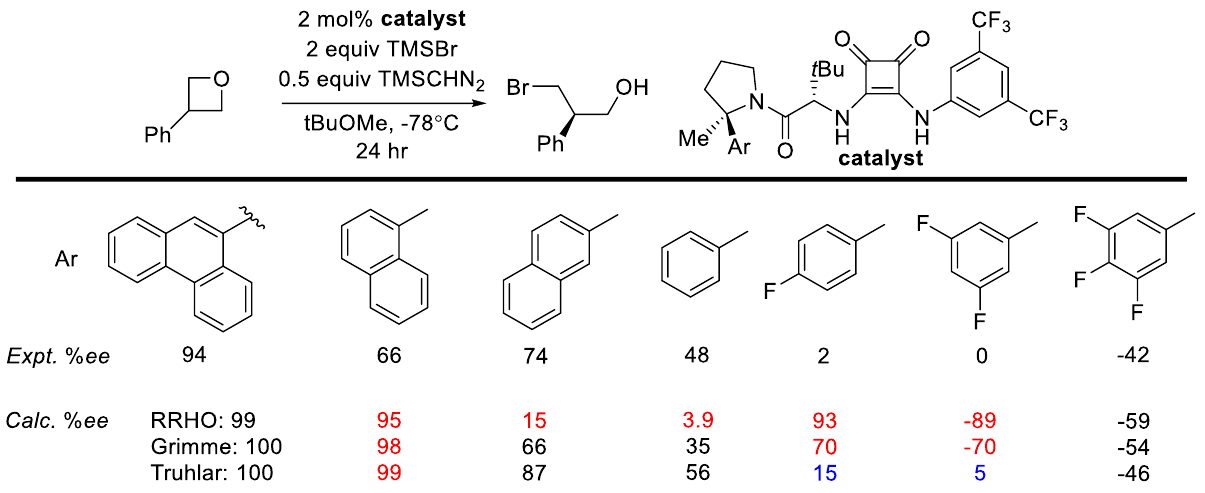
Figure 26. Squaramide-catalyzed enantioselective oxetane opening. Values are from the work of Jacobsen and co-workers [89]. Only the Lewis acid mechanism result is shown here. % ee are calculated from the ΔΔ G ‡ 195.15K, 1atm calculated at SMD(Et 2 O)/B97D3/def2-TZVP//SMD(Et 2 O)/B97D/def2-SVP as reported by the cited reference.